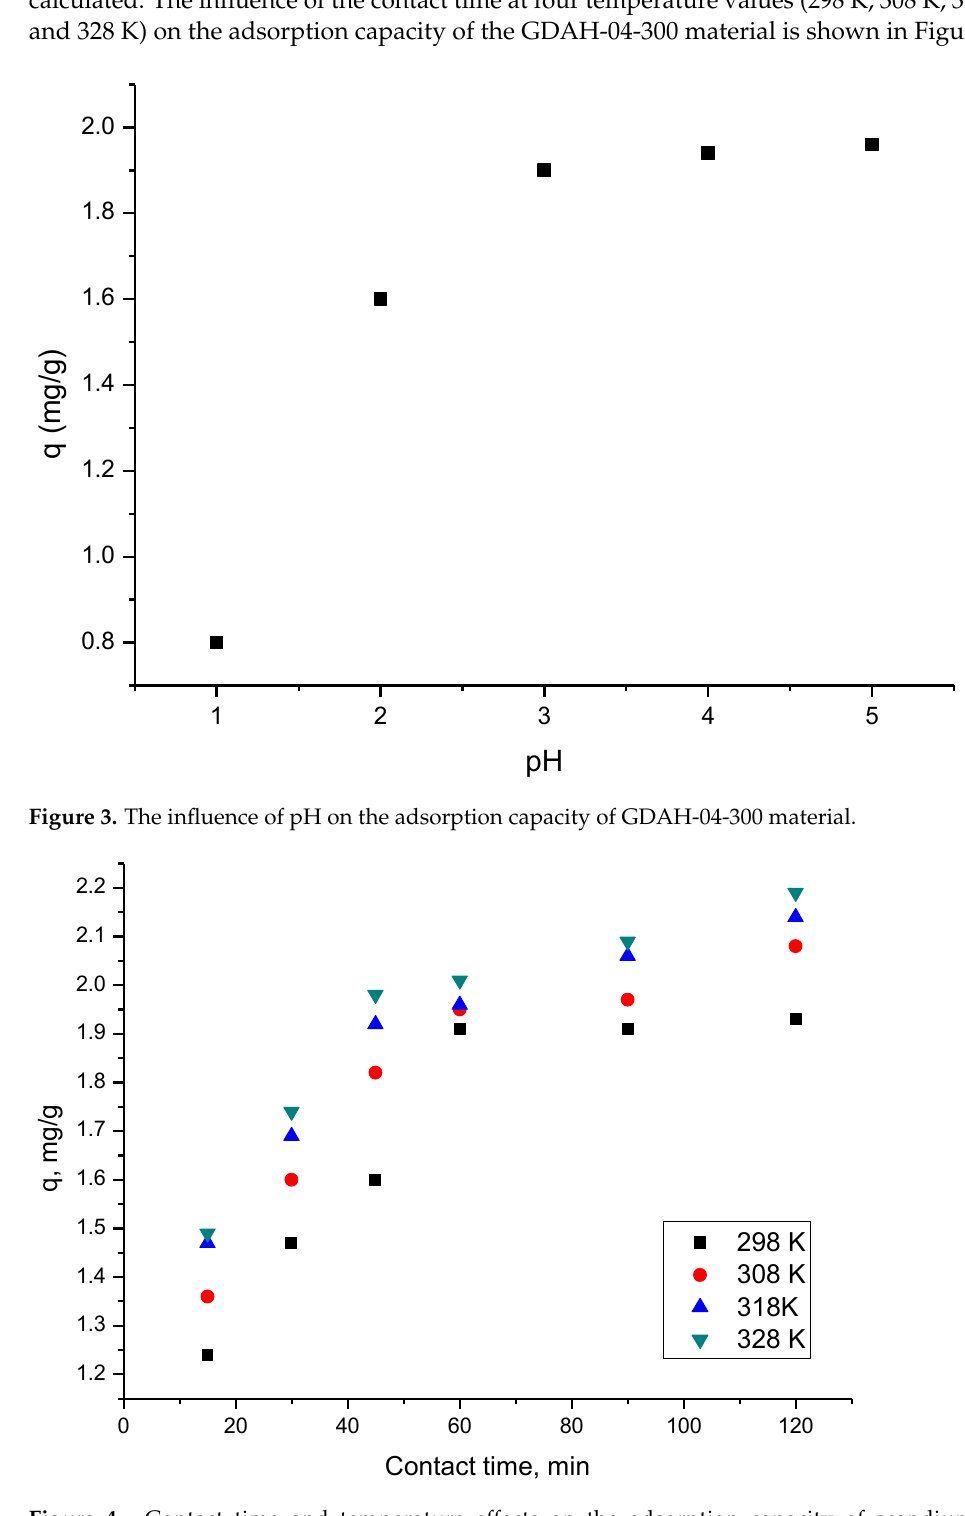
Figure 4. Contact time and temperature effects on the adsorption capacity of scandium on sample GDAH-04-300.